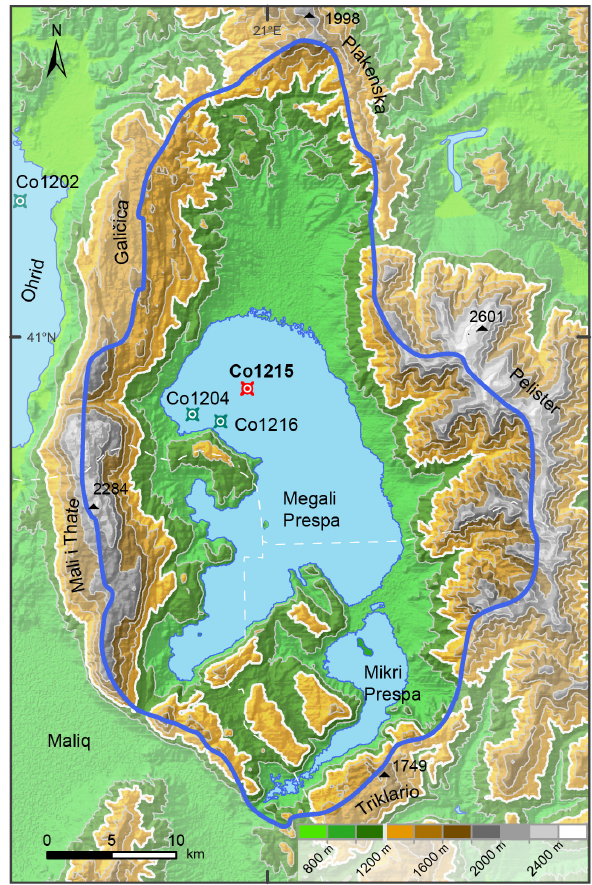
Fig. 2. Topography of Lake Prespa. Lake catchment (blue line) and core locations (Co1215, this study) are shown (SRTM Data: Jarvis et al.,